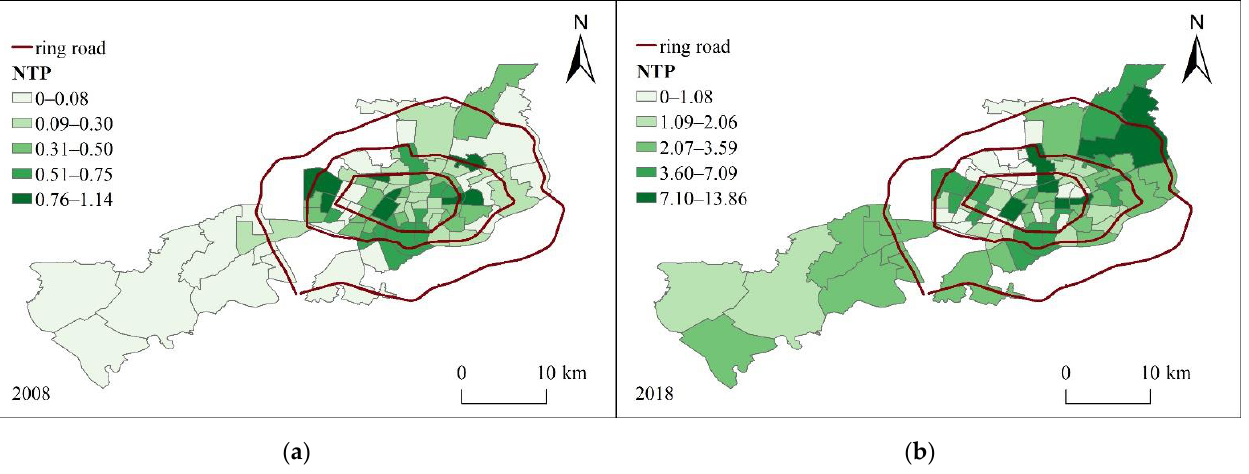
Figure 7. NTP of public toilets in Shenyang: ( a ) distribution of NTP in 2008; ( b ) distribution of NTP in 2008.